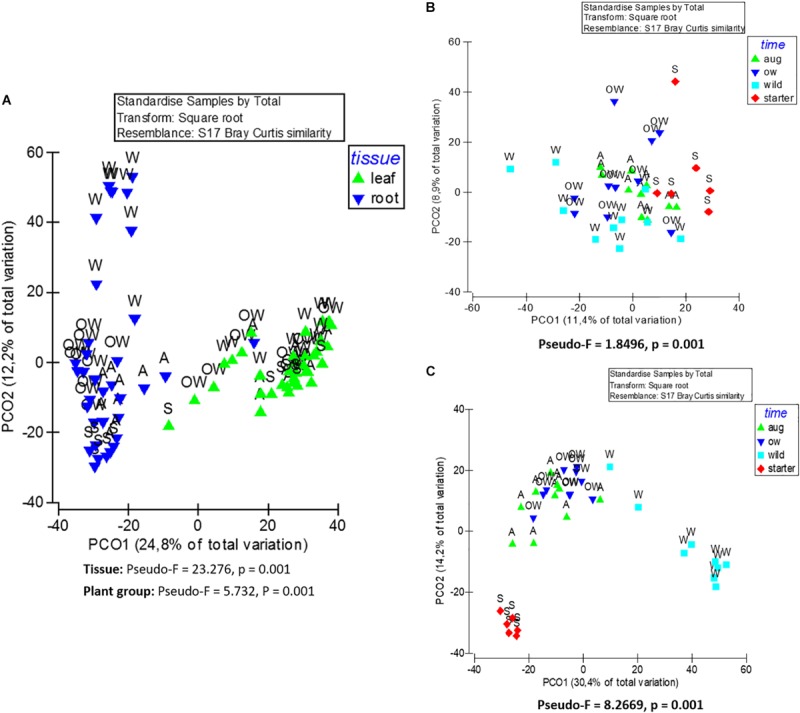
Principle coordinate analysis (PCoA) of endophytic bacterial (16S rRNA) community composition from (A) leaf and root samples, (B) root samples, and (C) leaf samples of O. digyna. The analyses are based on Bray–Curtis similarity matrix, and were performed with PRIMER software version 6. The pseudo-F and p values were obtained from PERMANOVA. S, starter = bait plants before field; A, aug = bait plants after field; OW = over-wintered bait plants; and W, wild = wild plants.